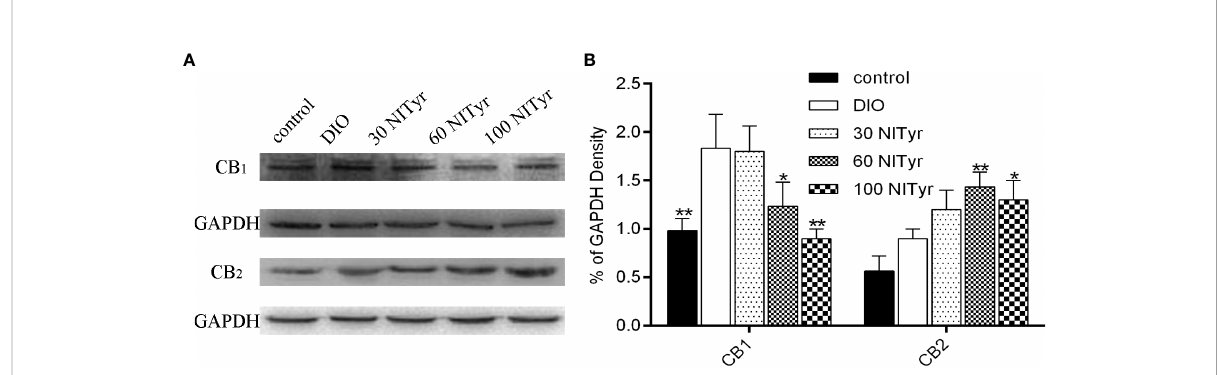
FIGURE 7 Effect of NITyr on the expression of CB 1 and CB 2 in brain. (A) Western blot analysis of CB 1 and CB 2 . (B) CB 1 and CB 2 expressions were normalized that of GAPDH. The control or DIO group was treated with Poloxamer 188 aqueous solution. 30 NITyr, 60 NITyr and 100 NITyr were treated with 30 mg/kg NITyr, 60 mg/kg NITyr, 100 mg/kg NITyr, respectively. All values were expressed as means ± SD. (n = 3). * P < 0.05, ** P < 0.01, as compared with the DIO